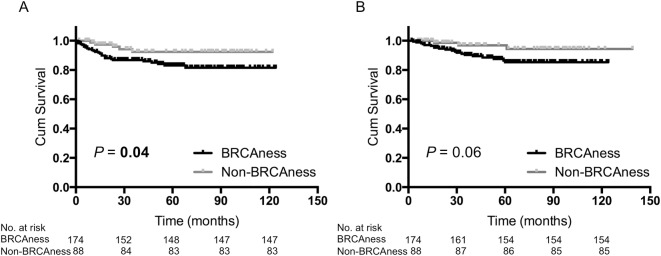
Kaplan–Meier analysis of patients with TNBC (n = 262).(A) Recurrence-free survival of BRCAness tumors versus non-BRCAness tumors. (B) Overall survival of BRCAness tumors versus non-BRCAness tumors.